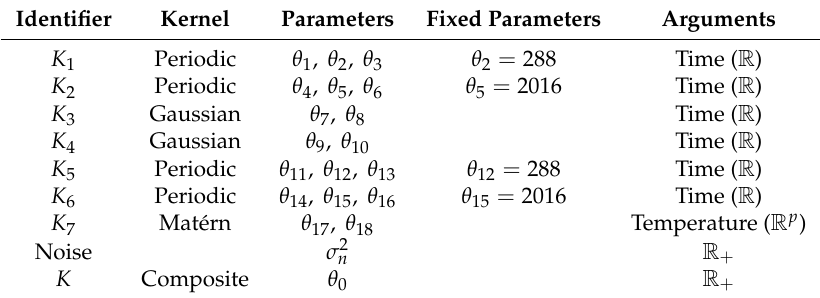
Figure 10. Forecasted load using a composite kernel with a decay away from strict daily and weekly periodicity, as well as a temperature component. Table 3. The parameters of the composite kernel described by Equation